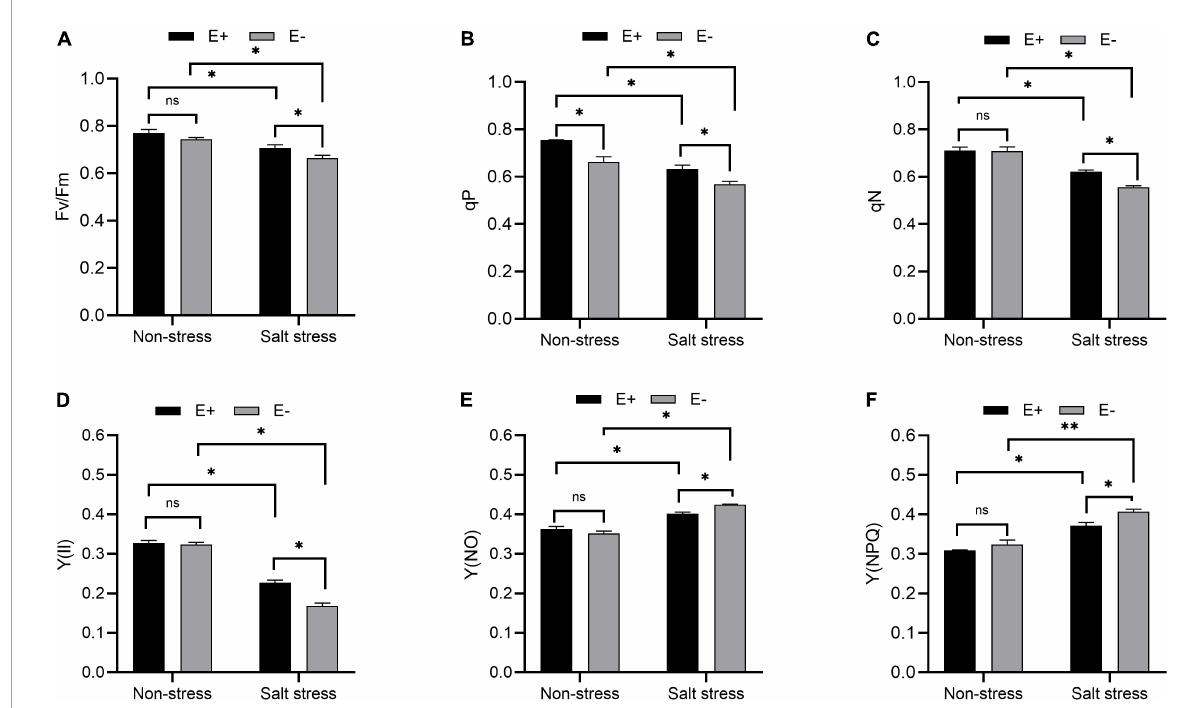
FIGURE3 Chlorophyll fluorescence parameter. Optimal/maximal quantum yield of PS II [ (A) ; Fv/Fm], photochemical quenching [ (B) ; qP], non-photochemical quenching [ (C) ; qN], quantum yield of PSII [Y(II); (D) ], Y(NO) (E) and Y(NPQ) (F) of bermudagrass with inoculated and uninoculated plants under salt stress. Bars denote means ± SE of four treatment. “Non-stress” represents bermudagrass grown without NaCl condition; “Salt stress” represents bermudagrass under 250 mM salt conditions. “E + ” represents the infection of Enterobacter ludwigii , “E − ” represents the absence of E. ludwigii. “ ∗ ,” “ ∗∗ ,” indicate significant differences at P < 0.05, and P < 0.01, and respectively, and ‘ns’ represents no significant difference.